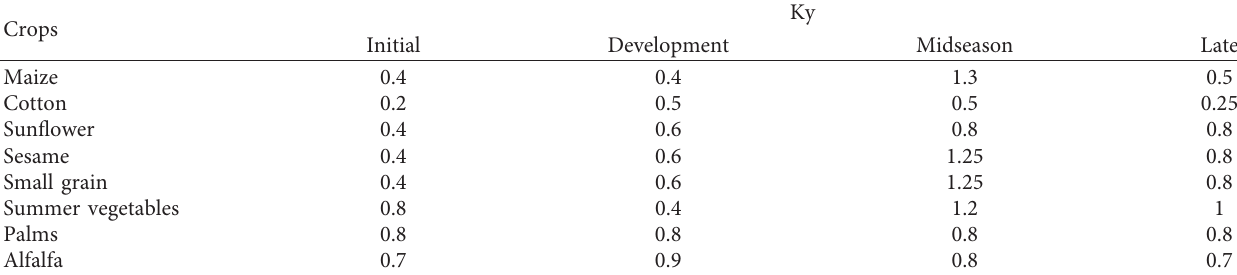
Table 2: Values of the yield response factor (Ky) for crops related to the project of Al-Hussainiyah irrigation [42]. Crops